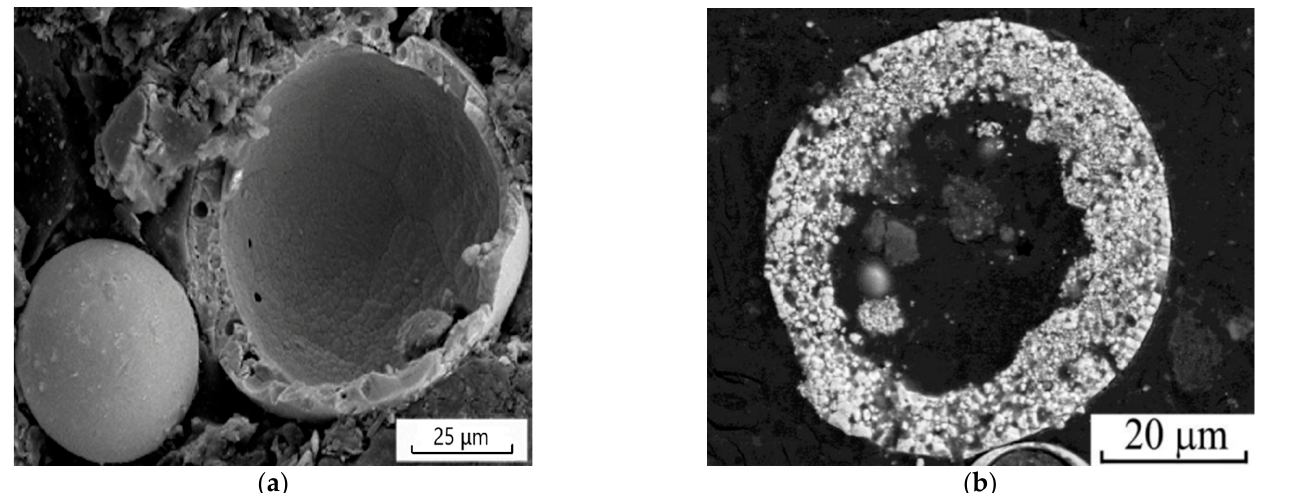
Figure 1. Microstructure of Metco204NS powder: ( a ) globular; ( b ) Cross-sectional.